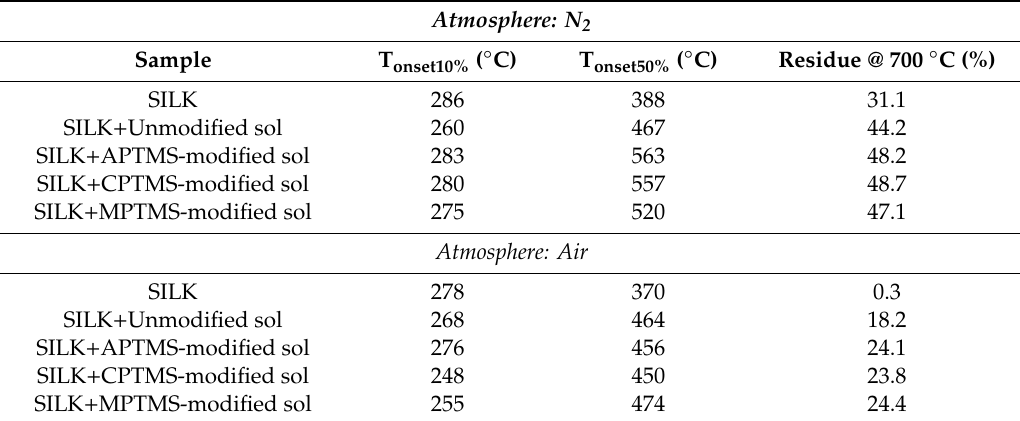
Table 15. Results from the thermogravimetric analyses for untreated and sol-gel-treated silk fabrics.